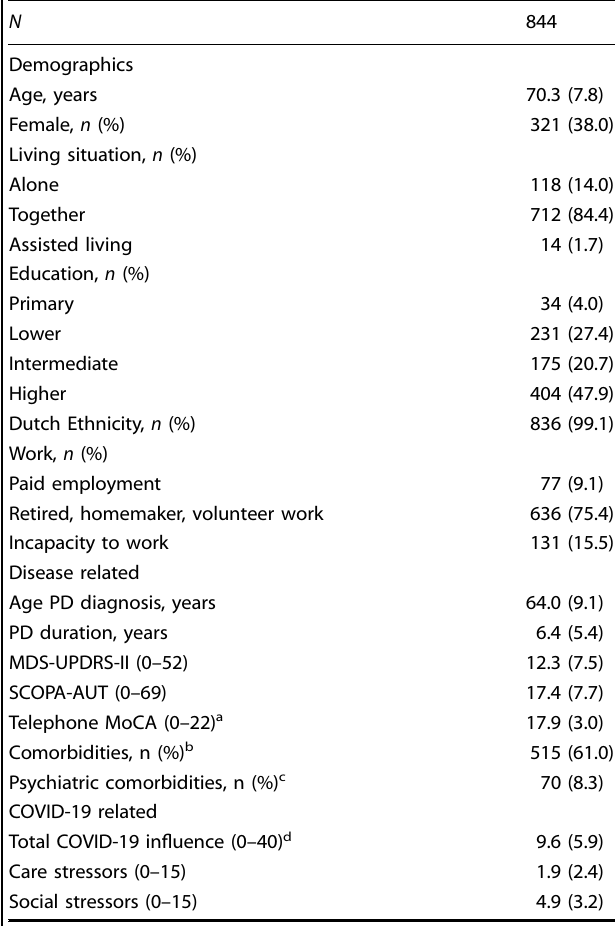
Table 1. Baseline